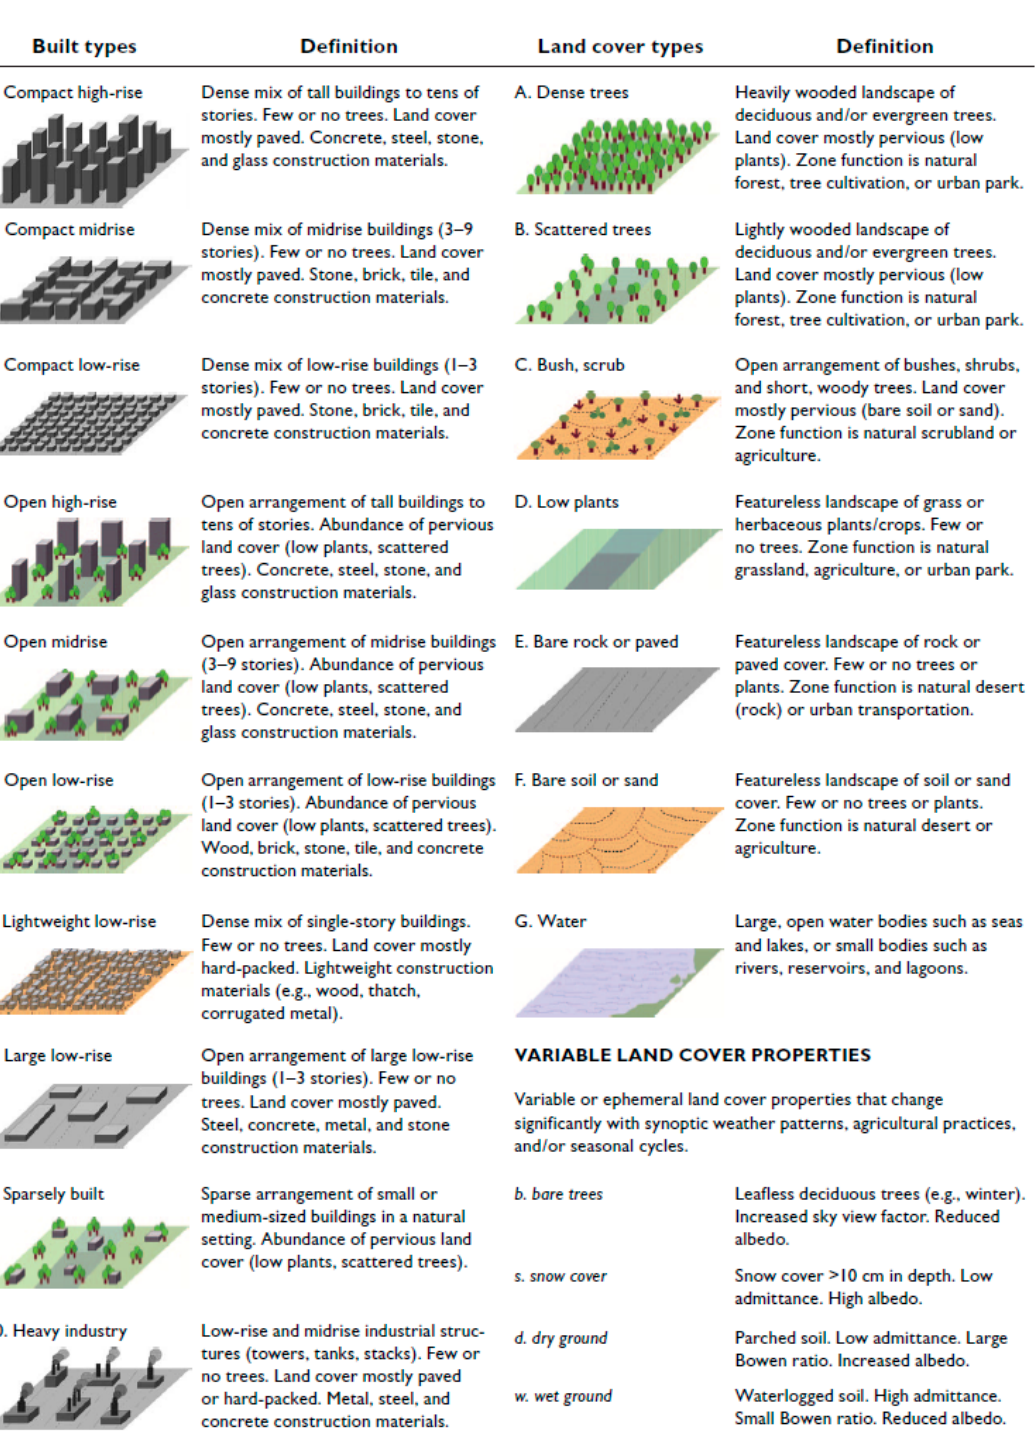
Figure 2. Schematic of local climate zones, cited from Stewart and Oke [8] . (2) Temporal Aggregation of LST The monthly and seasonal LST are calculated by the following equations [28,31], and taking LST QC into account.